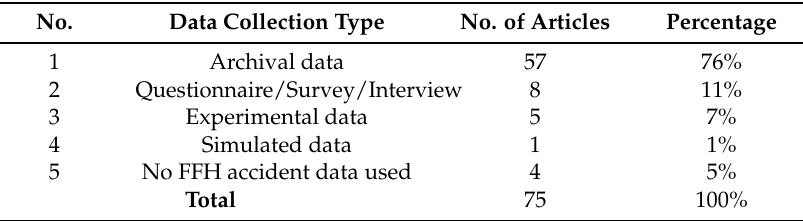
Table 6. Data collection strategies.